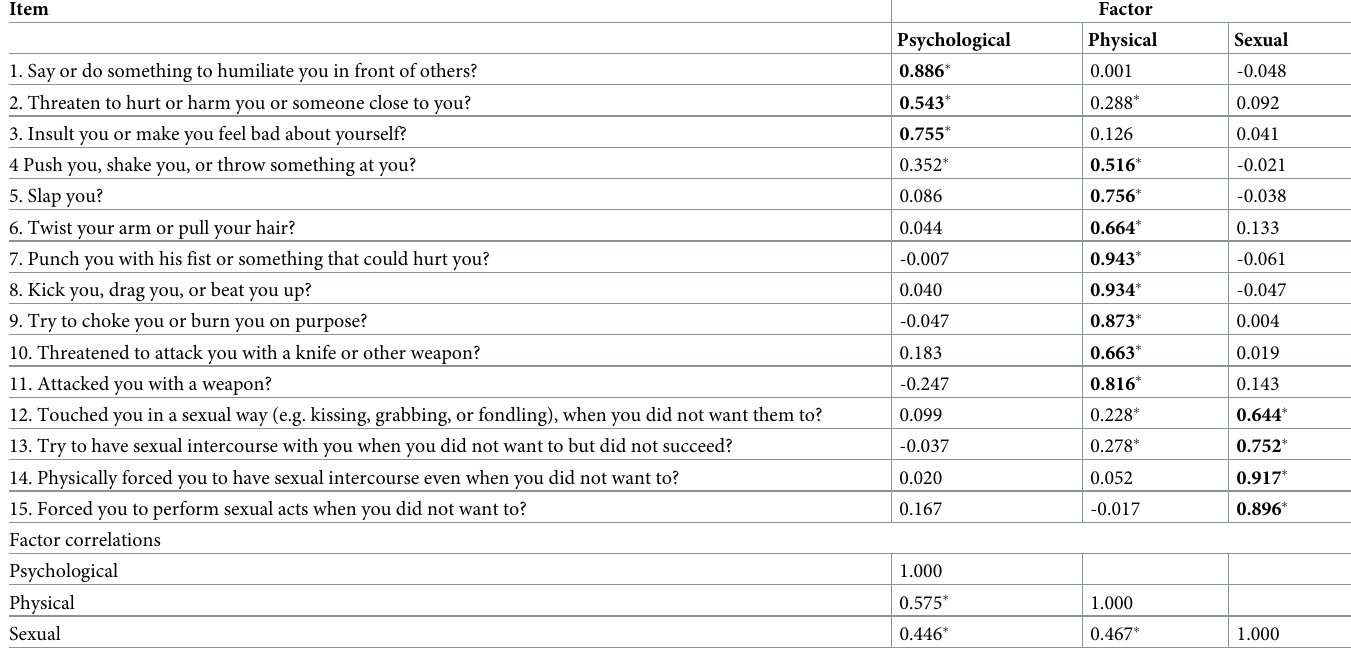
Bold values indicate hypothesized major loadings; � indicates values are significant at 5% level; ESEM, exploratory structural equation